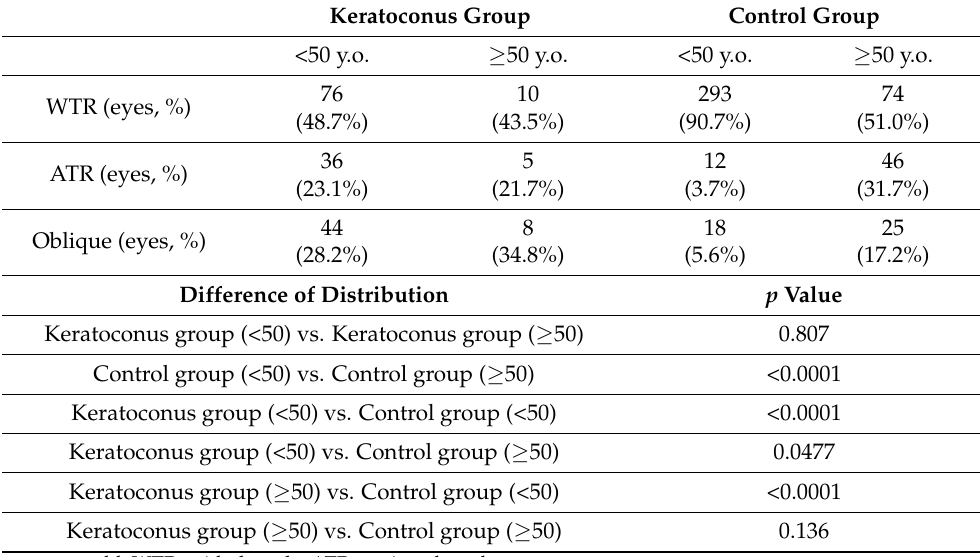
Table 2. Comparison of corneal astigmatism axis